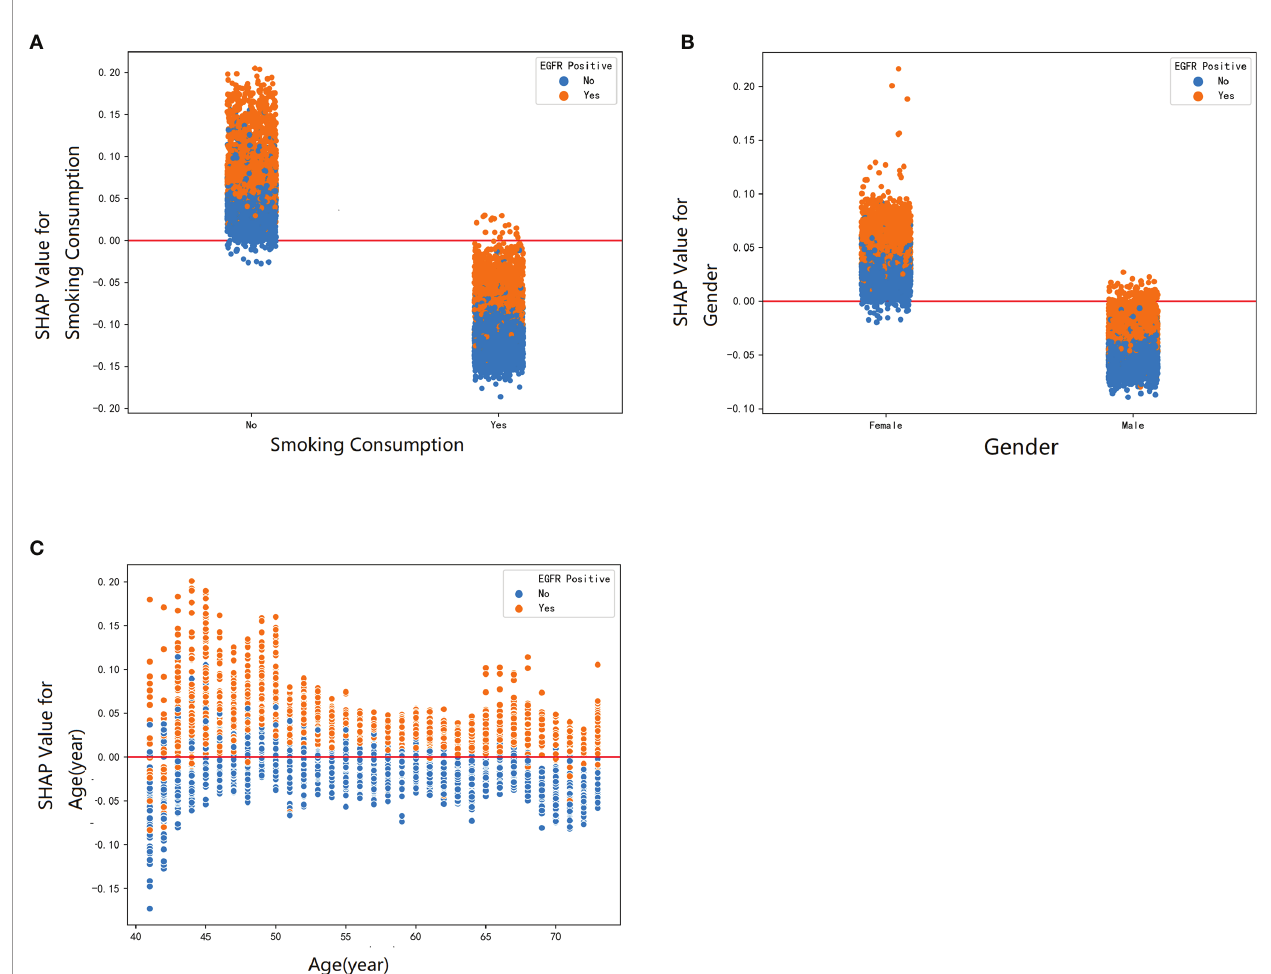
FIGURE 4 | The SHAP dependence plot was used to explain how a single factor affects the result in this RF model. SHAP value for speci fi c feature exceeding zero represents an increased risk of incidence of EGFR mutation. The demographic factors: (A) smoking consumption, (B) gender, and (C)